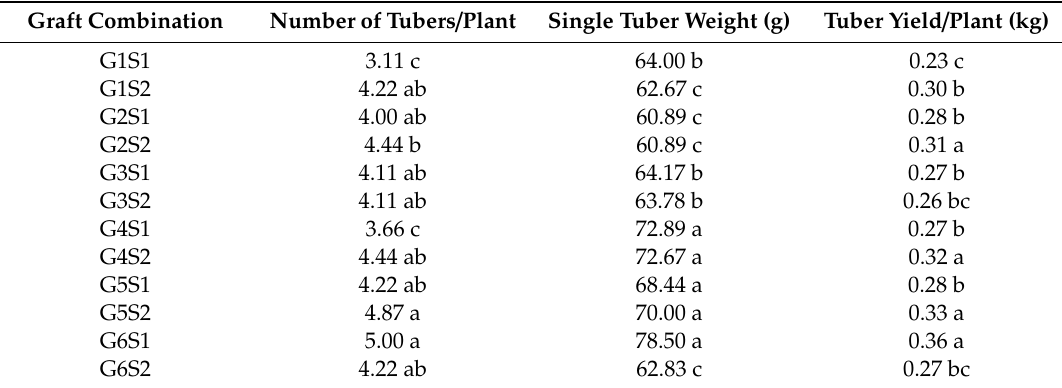
Table 5. E ff ect of di ff erent grafting combinations on potato tuber yield of pomato plants. Graft